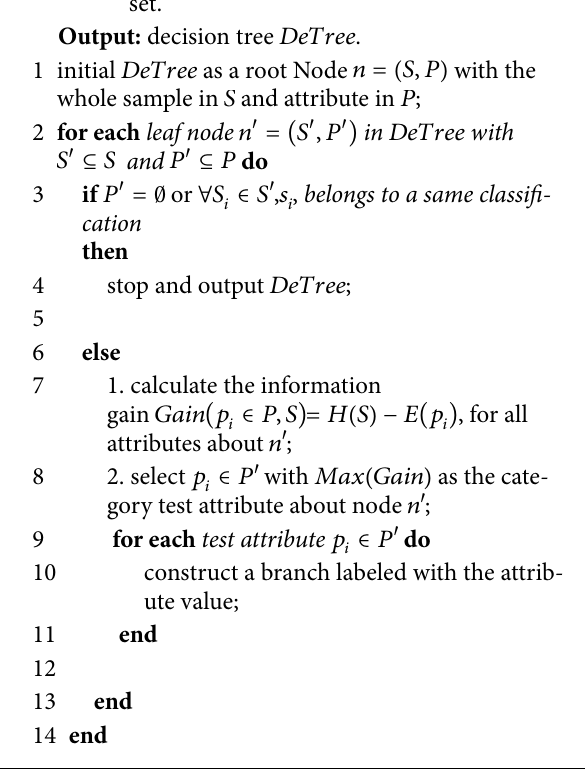
Algorithm 1: ID3: decision tree construction